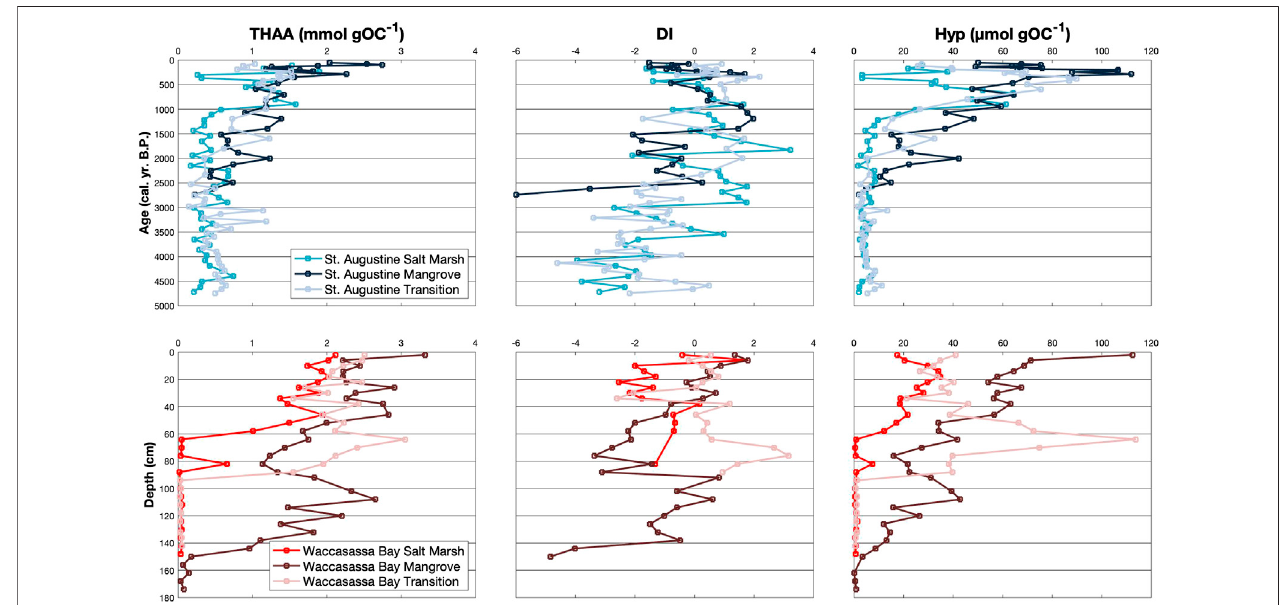
FIGURE 4 | Down-core measurements of THAA (mmol gOC − 1 ), DI, and Hyp ( μ mol gOC − 1 ) for cores in St. Augustine (top) and Waccasassa Bay (bottom) . St. Augustine cores are plotted against calibrated ages (cal. yr. B.P.) and Waccasassa Bay cores are plotted against depth (cm).